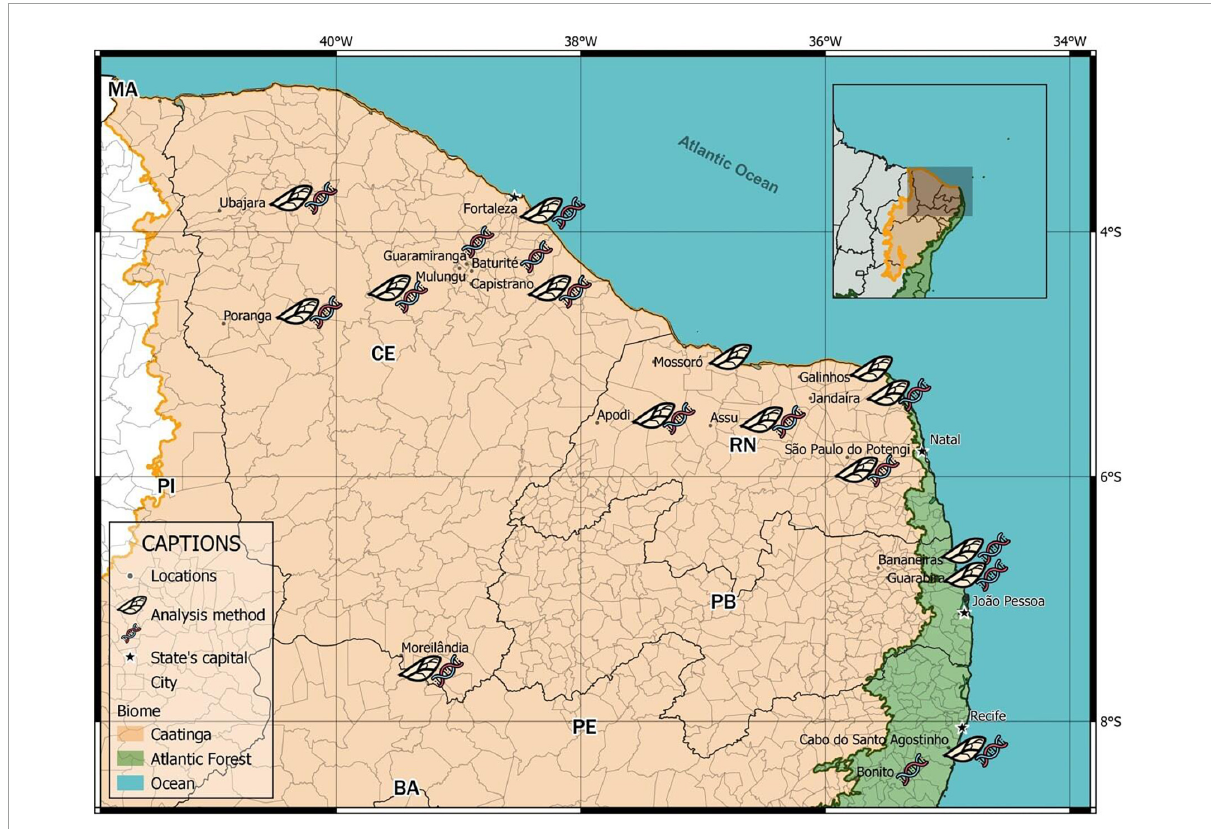
FIGURE1 Plebeia flavocincta sampling locations across Northeast Brazil over a map with the two main biomes of the region (Caatinga and Atlantic Forest) showing the two methods used (wing morphometry and molecular analysis). Only one type of analysis was used in some locations.